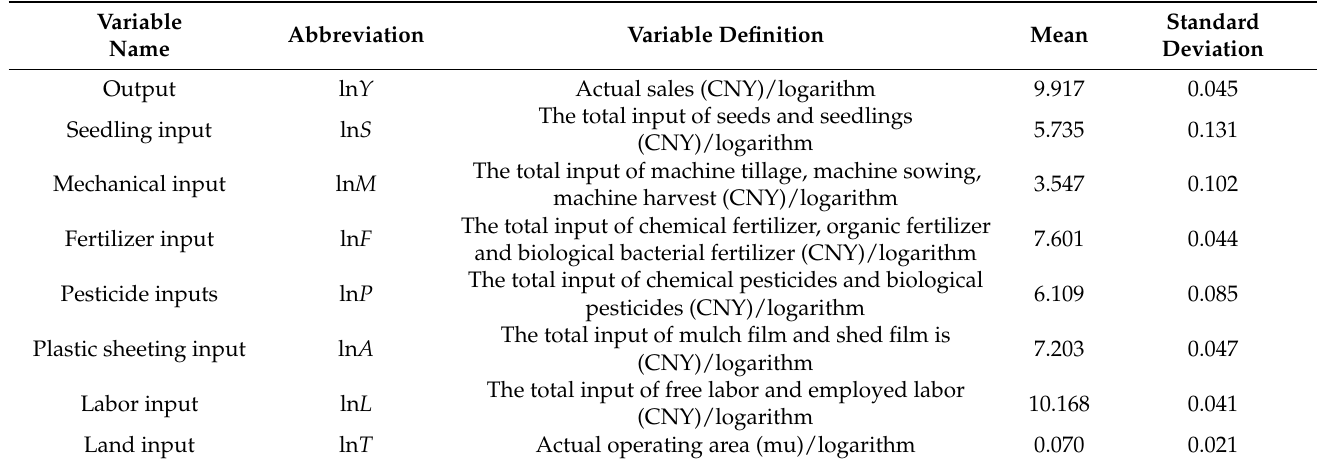
Table 1. Calculation basis for the technical efficiency of farmers’